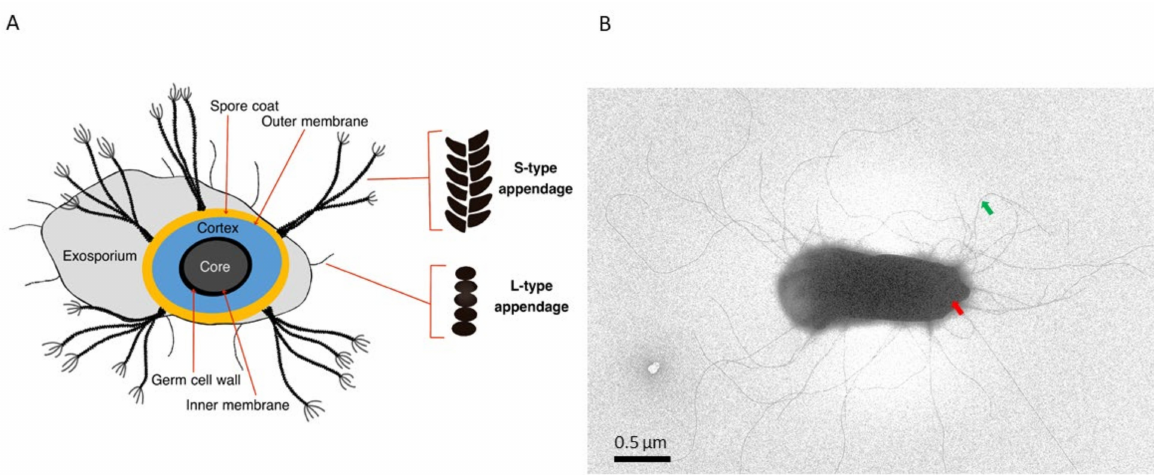
Figure 1. B. cereus endospore decorated with multiple hair-like appendages. ( A ) Illustration showing a cross-section of a B. cereus spore revealing multiple concentric layers, the exosporium and endospore appendages (S-Ena and L-Ena). The sizes of the spore layers and appendages are not drawn to scale. ( B ) Negative stain transmission electron microscopy (TEM) image of B. cereus NVH0075-95 spore showing the spore body (red arrow) and hair (pilus)-like appendages (S-Ena) (green